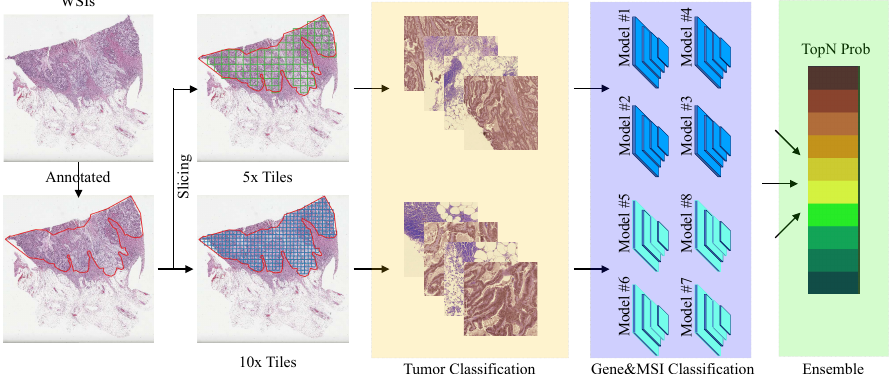
Figure 2. Experimental workflow for estimating somatic gene mutation and microsatellite instability with H&E stained whole-side images. The 5 × or 10 × tiles from WSIs will be accessed by a tumor classifier, a gene&MSI classifier, and a TopN ensemble